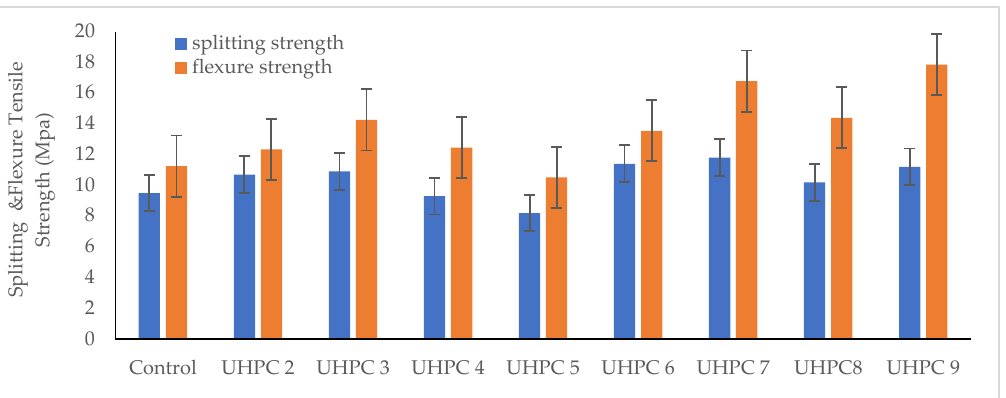
Figure 6. Flexural and splitting strengths after 90 days for glass and lime powder replacement ratios.